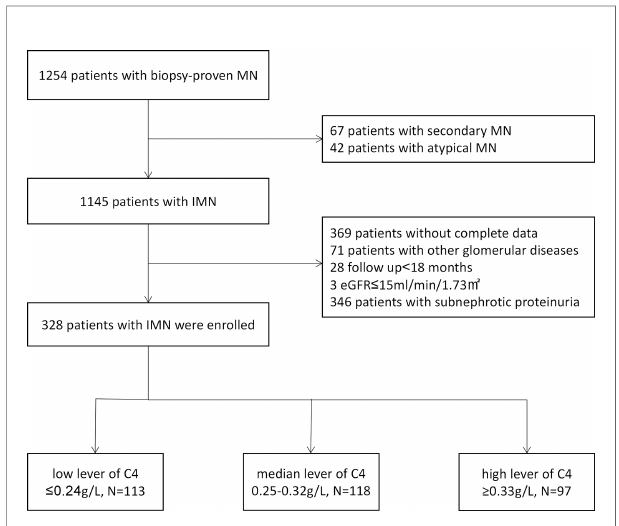
FIGURE 1 | Patient selection fl owchart. MN, membranous nephropathy; IMN, idiopathic membranous